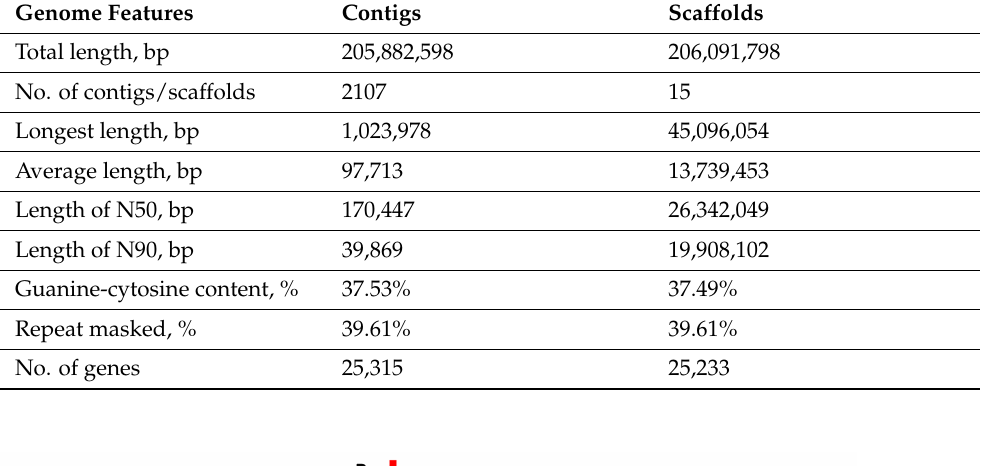
Table 3. Summary of flat peach ‘124 Pan’ genome assembly features.